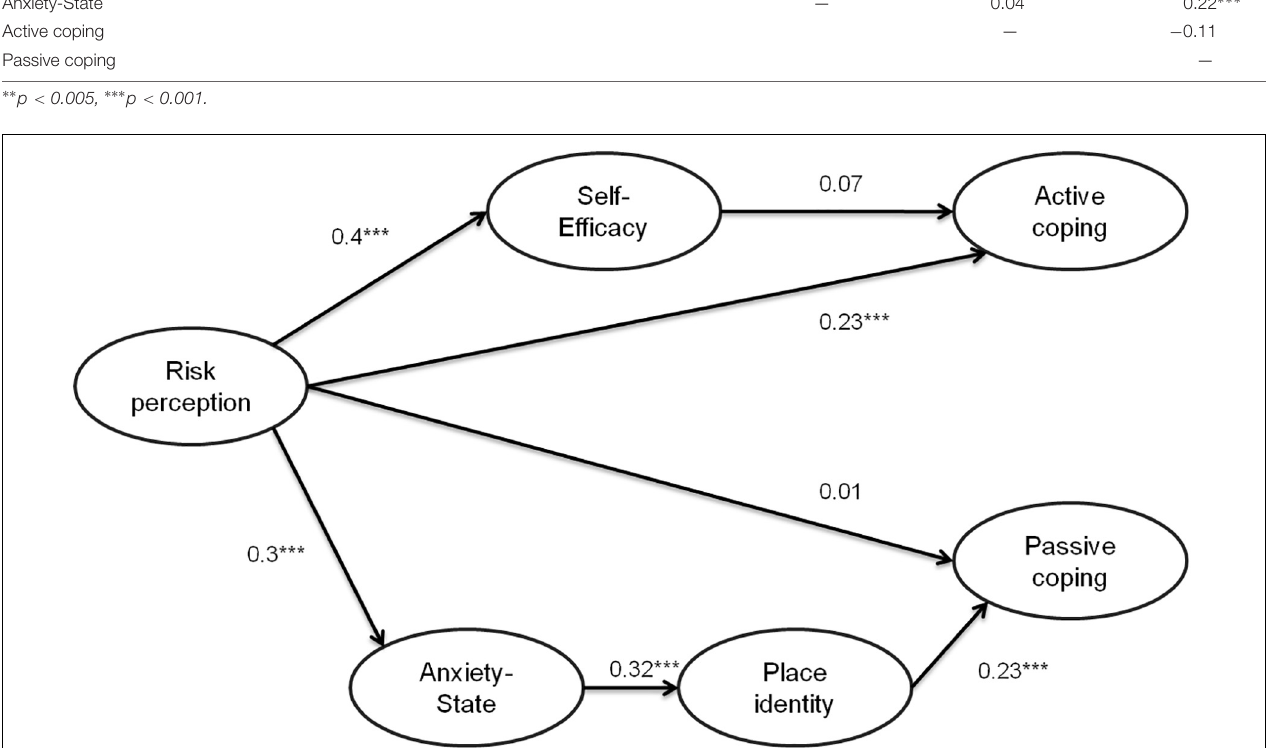
FIGURE 2 | Path modeling results for M 1 . (1) Reported numbers are standardized regression coefficients ( β ) indicating direct effects. (2) N = 315 4. ∗∗∗ p <